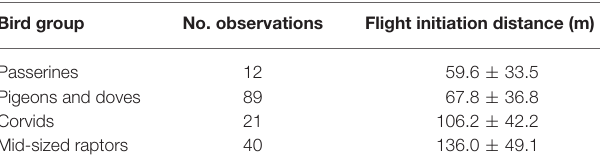
TABLE 1 | Flight initiation distance (mean ± SD) of birds facing an approaching high speed train. Bird